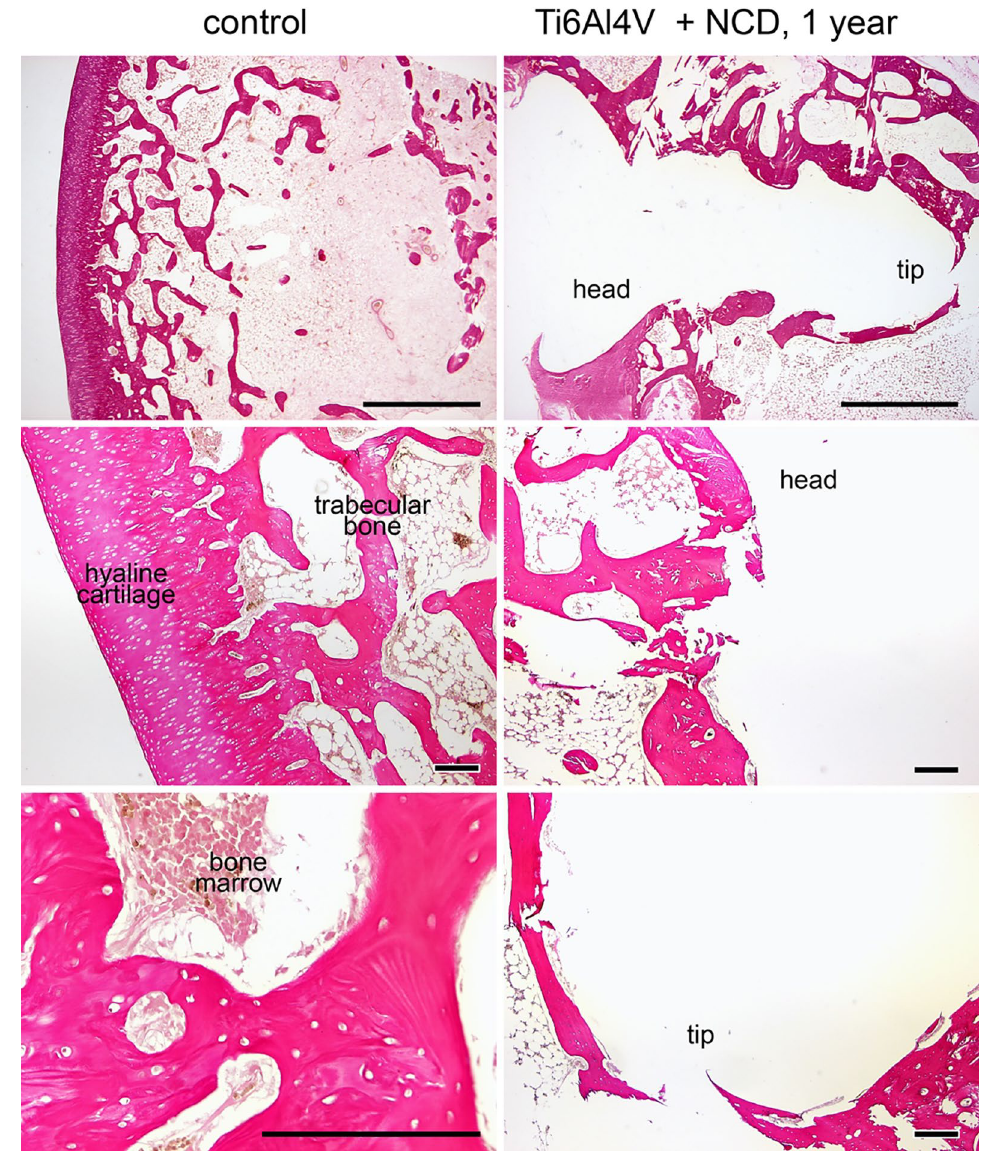
row), while the tip is covered by newly-formed bone (bottom row). Van Gieson/orcein staining (top row) and hematoxylin–eosin staining, scale bars 1 mm (top row) and 200 µm (remaining panels). Control = unoperated